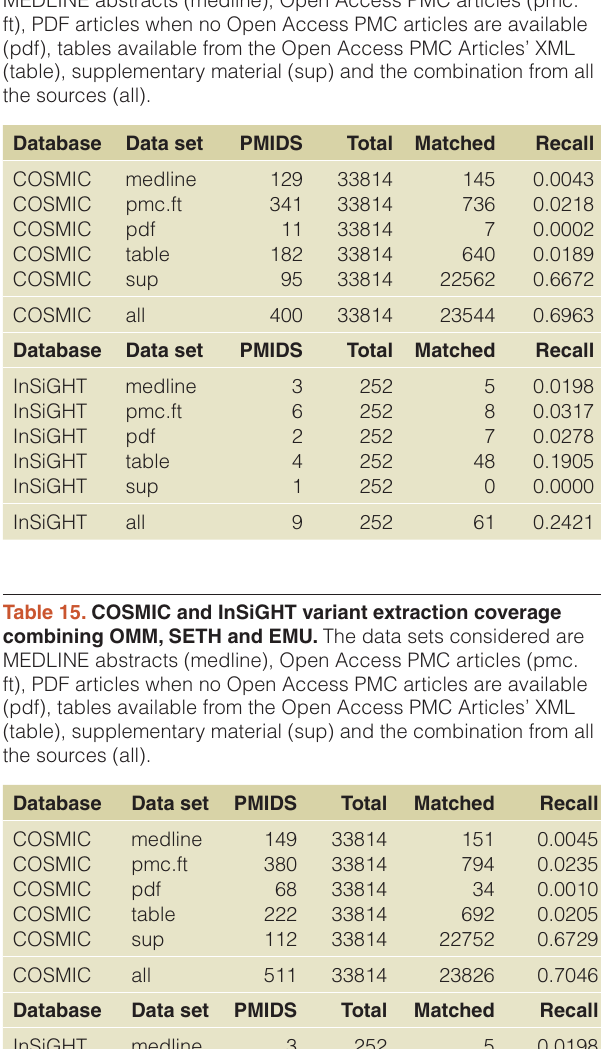
Table 14. COSMIC and InSiGHT variant extraction coverage combining OMM and SETH. The data sets considered are